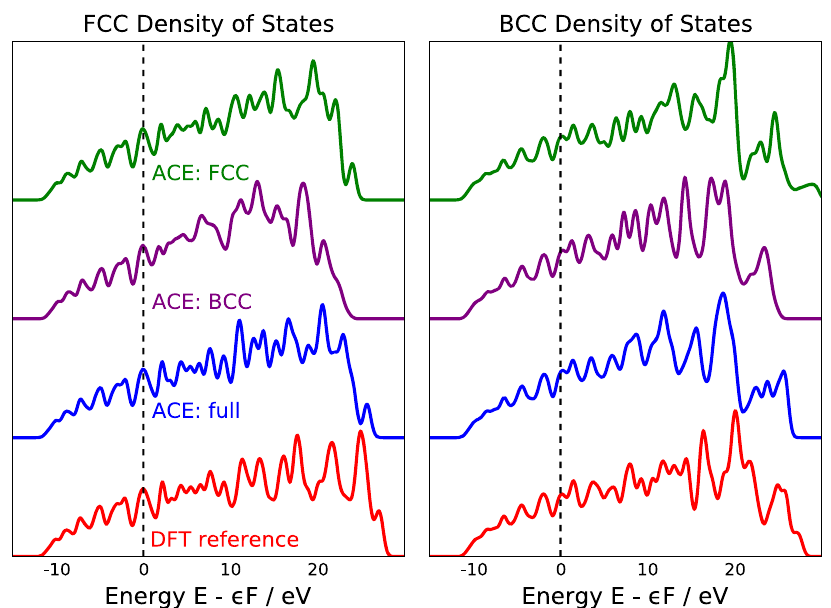
Fig. 8 Comparison of FCC and BCC DoS predicted with ACE models for full and restricted training databases. The reference DFT DoS is shown in red. A vertical shift has been applied to separate the DoS for each ACE model.